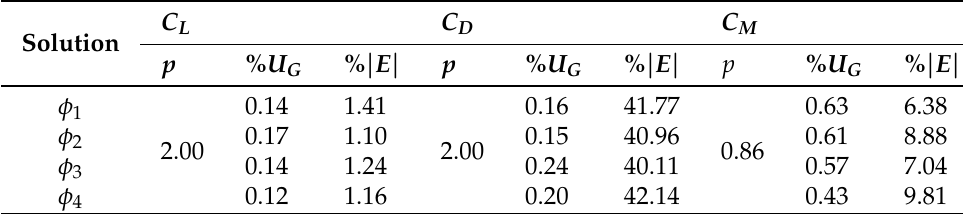
Uncertainty estimations for Hybrid-mesh (Element size = 0.17678 c ,0.12500 c ,